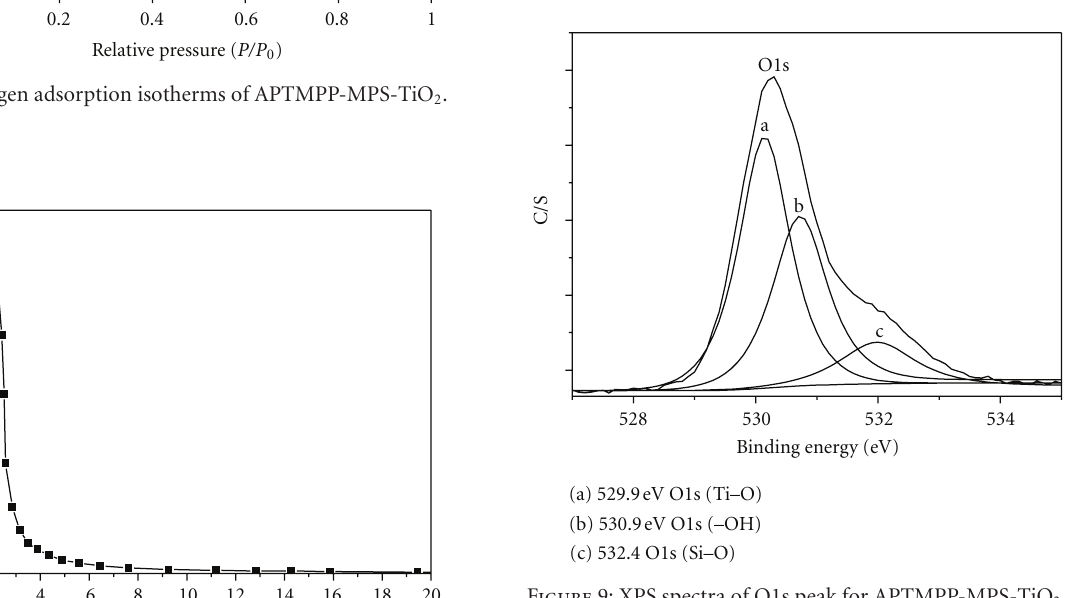
Figure 9: XPS spectra of O1s peak for APTMPP-MPS-TiO 2